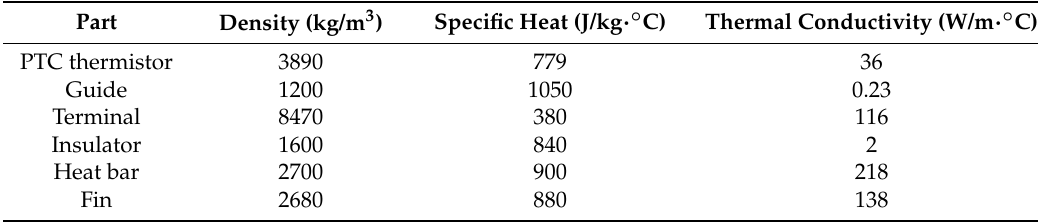
Table 5. Thermal properties of respective